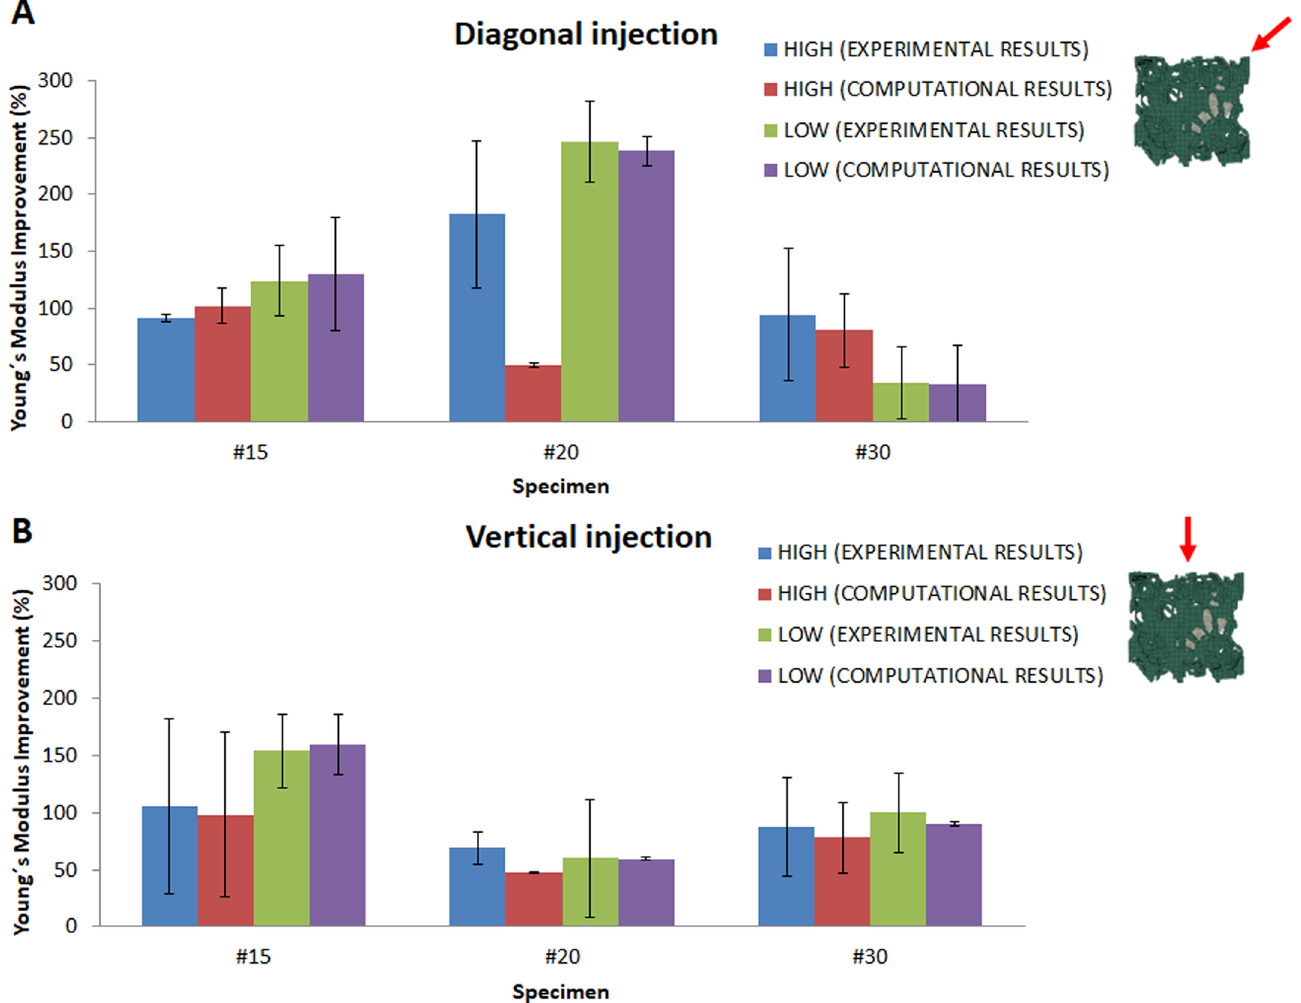
Fig 3. Mean Young’s modulus improvement (%) in all the cases tested in vitro and in silico: (A) vertical and (B) diagonal directions of injection. Bars indicate the standard deviation values (see Table